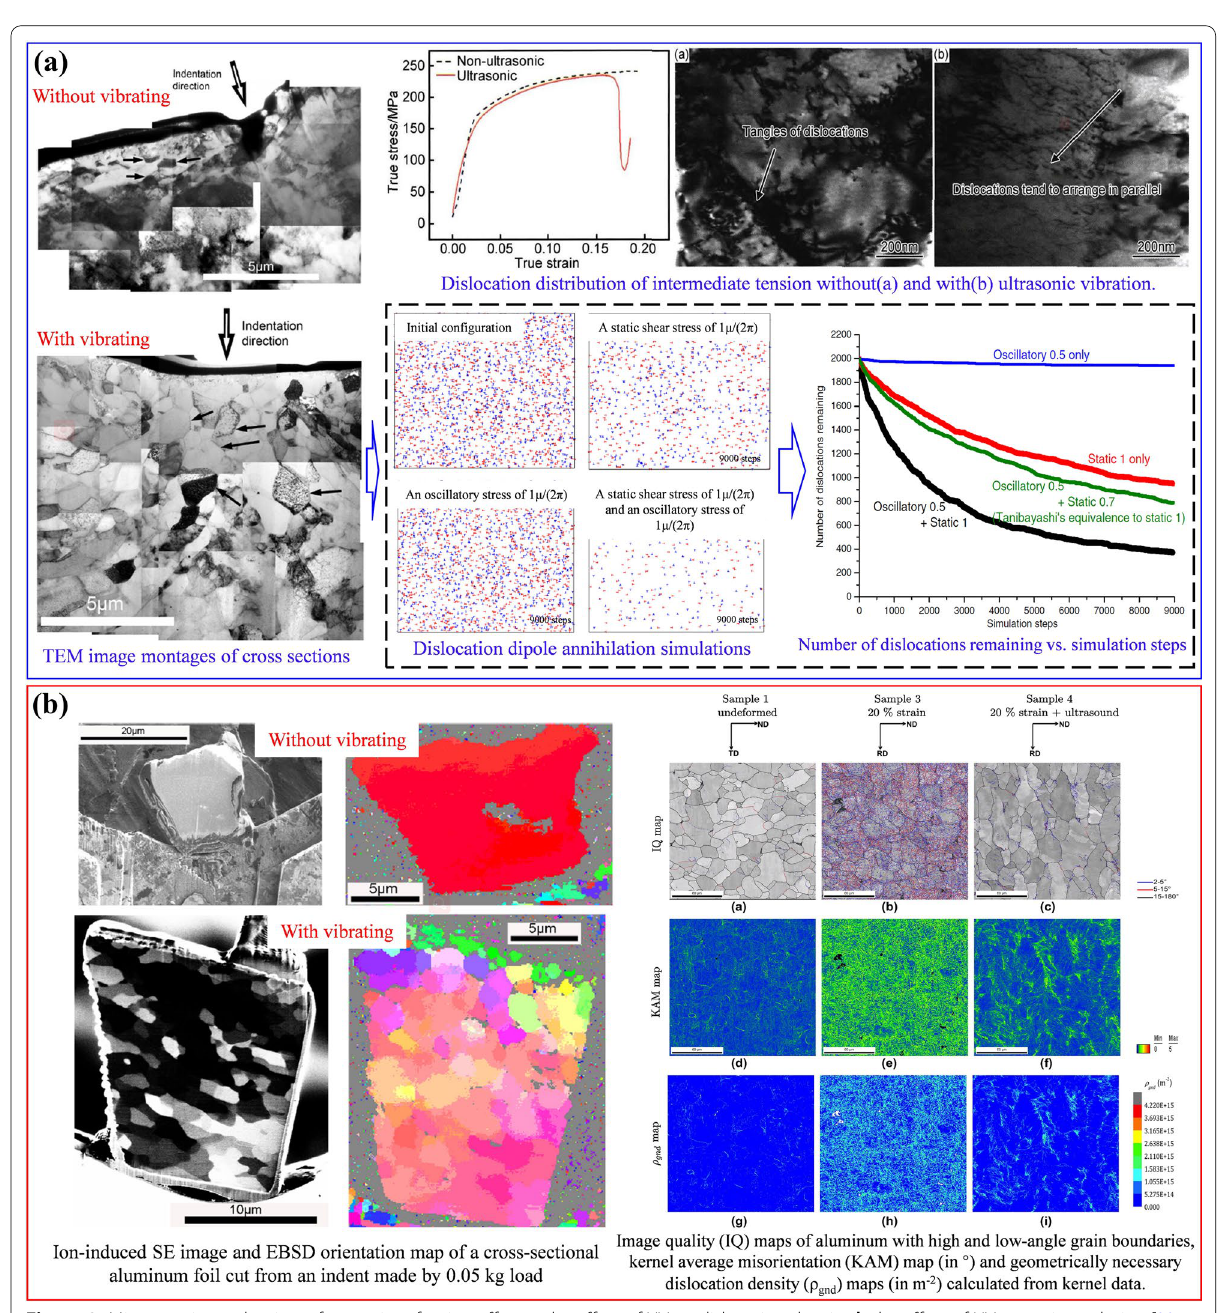
Figure 3 Microscopic mechanism of acoustic softening effect: a the effect of UV on dislocation density, b the effect of UV on grain evolution [33,